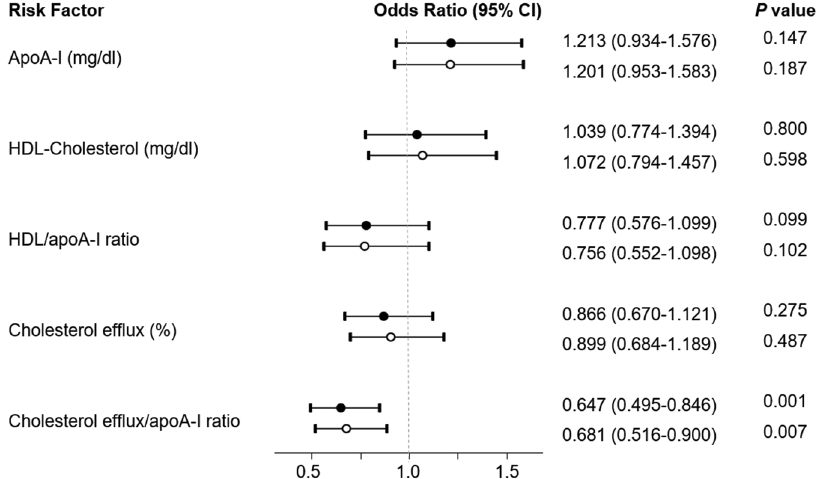
Figure 2. Odds ratio (95% CI) for T2DM. Odds ratio for continuous variables are per 1-SD increase. Logistic regression model 1 ( ● ) adjusted by age, sex, BMI, smoking status, alcohol drinking, lipid-lowering treatment, hypertension, serum triglycerides and batch number (in case of cholesterol efflux). In model 2 ( ○ ) additional adjustment by HbA1c, HOMA-IR and Disposition Index was done.